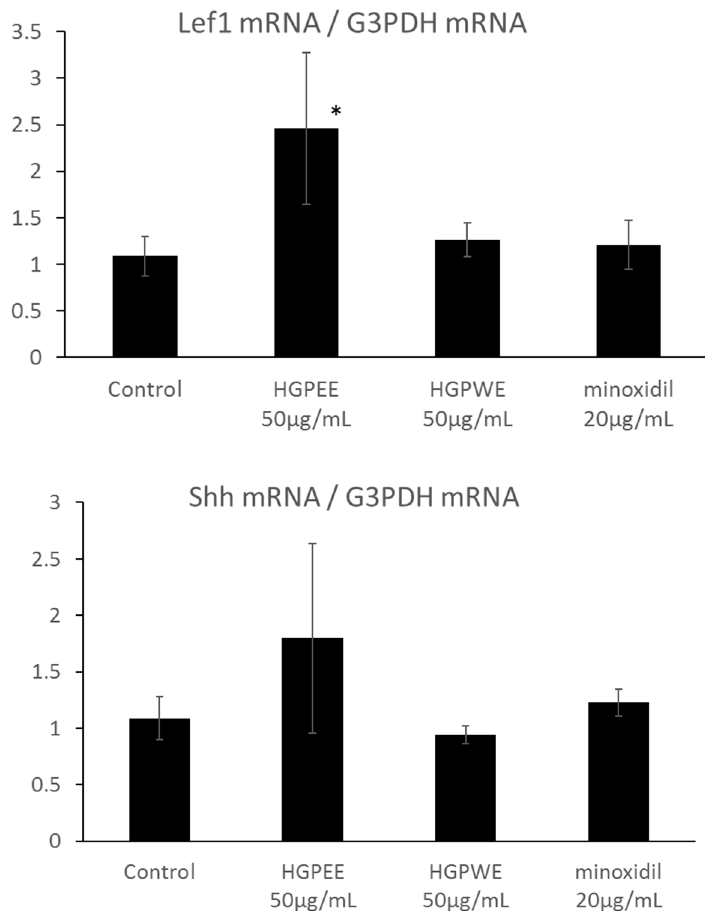
Figure 4. Effect of HGPEE, HGPWE, and minoxidil on the mRNA expressions of Wnt10b, Lef1, and Shh in cultured human fetal epidermal keratinocytes. n = 3, mean ± S.D., * p < 0.05 vs. Control, ** p < 0.01 vs. Control, + p < 0.1 vs. Control.